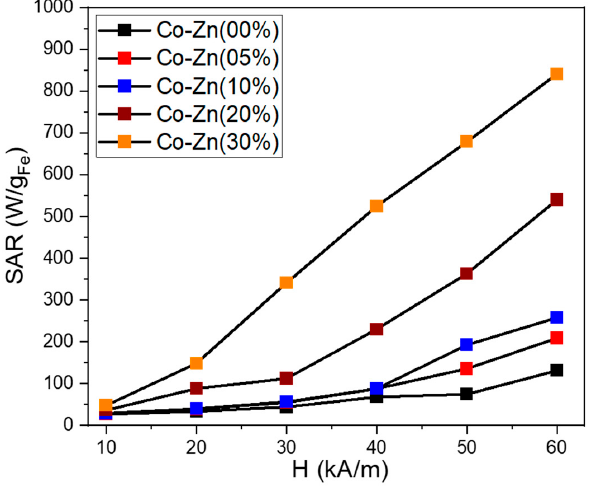
Figure 10. The magnetization values in 4 T of Co 1 − x Zn x Fe 2 O 4 nanoparticles at 300 K.